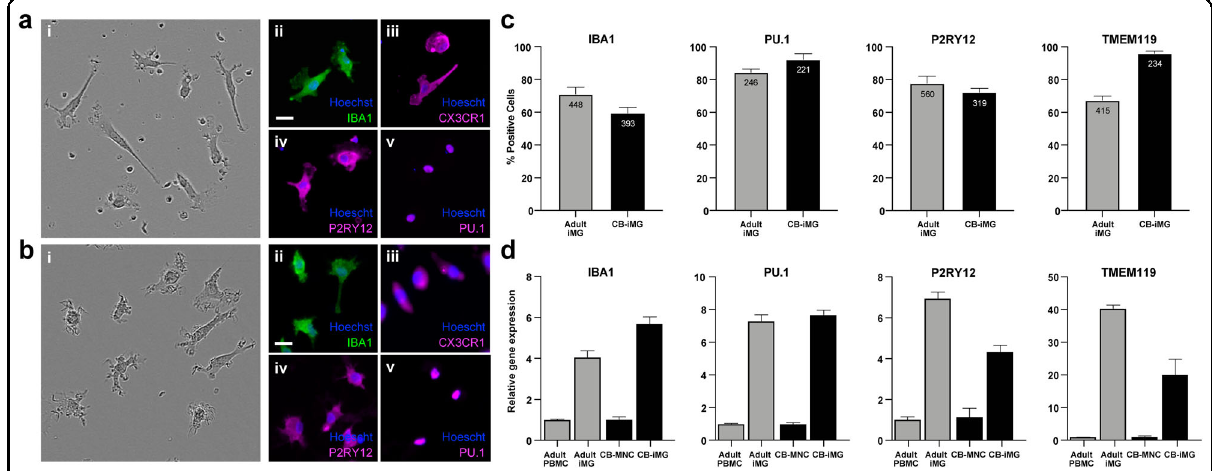
Fig. 1 Characterization of monocyte-derived induced microglia-like cells (iMGs) by direct cytokine reprogramming. a Umbilical cord monocyte-derived CB-iMGs. b Adult PBMC-derived iMGs. (i) Morphology by phase contrast; immunostained images of iMG cells stained with nuclei (Hoechst) and indicated microglial markers (ii) IBA1, (iii) CX3CR1, (iv) P2RY12, and (v) PU.1. Scale bar: 30 μ m. c Quantitation of positively immunostained cells as a percentage of total cells (nuclei) for indicated microglial markers. Bars indicate mean of indicated no. of cells measured, error bars indicating SEM. d Quantitation of fold increase in gene expression of indicated microglial markers normalized to input (PBMCs and CB-MNCs, respectively) after iMG reprogramming, error bars indicating SEM ( n = 3